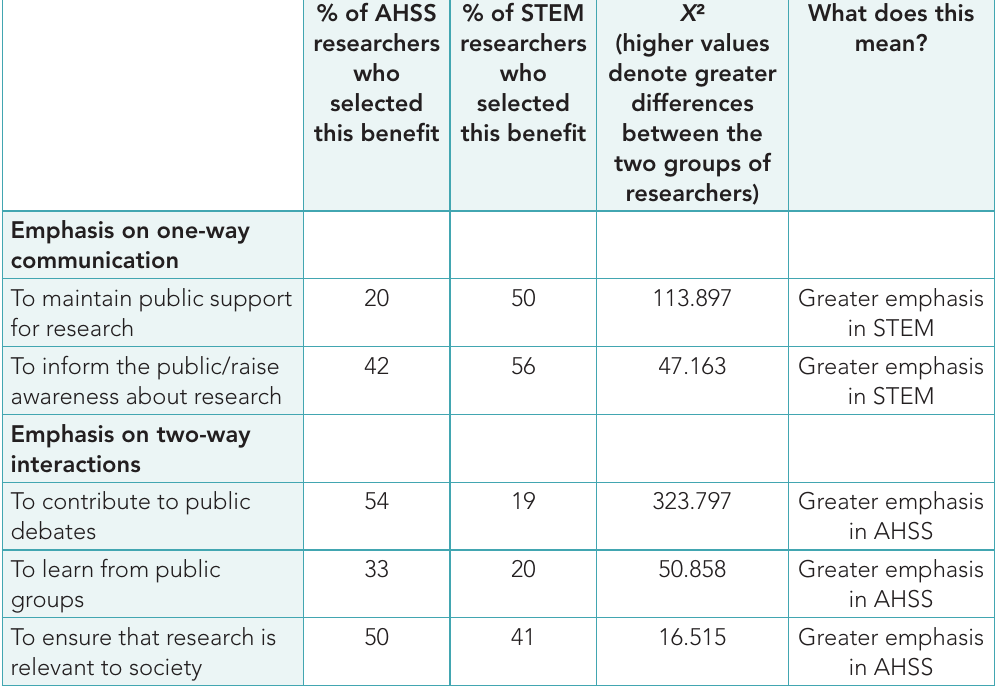
Table 12: Researchers’ understandings of the benefits of public engagement (all p -values are